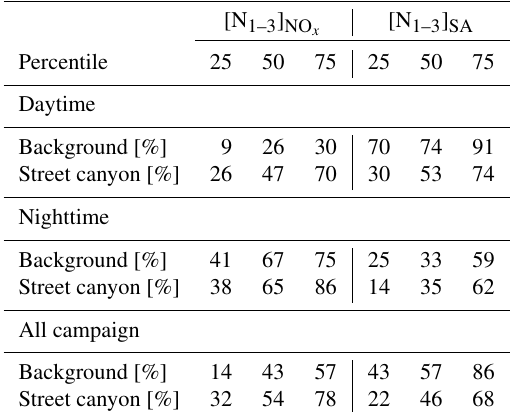
Table 4. The percentiles of the relative contributions of traffic and NPF to estimated sub-3nm particle concentrations at the back- ground station and the street canyon. [ N 1–3 ] NO present relative contribution of sub-3nm particle concentrations es- timated based on NO x and SA concentrations, representing the con- tributions of traffic and NPF, respectively. Equations used for calcu- lating the relative contribution of each source are presented in the appendix (Eqs. A5 and